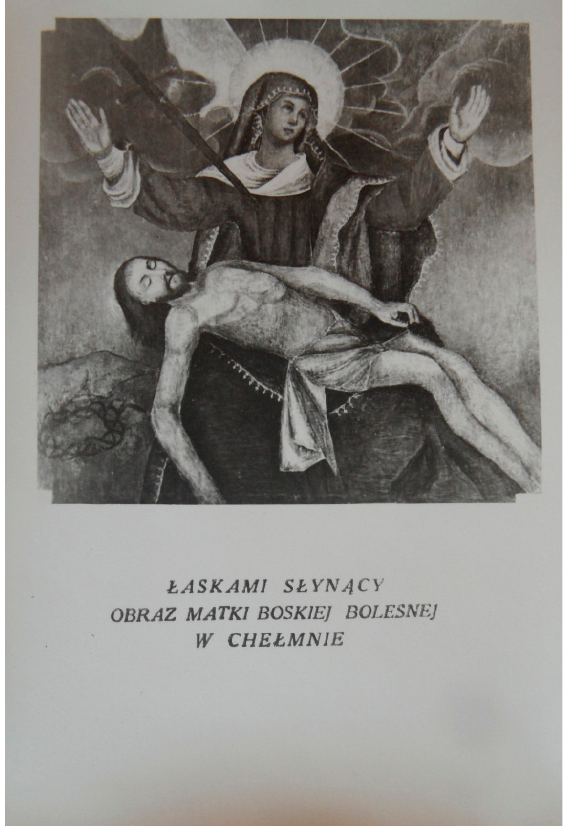
Figure 1. Black and white picture with the image of Our Lady of Chełmno, with an inscription at the bottom: IMAGE OF OUR LADY OF SORROWS IN CHEŁMNO; dim: height 15 cm, width 10 cm; in inv. MZCH/E/1102.